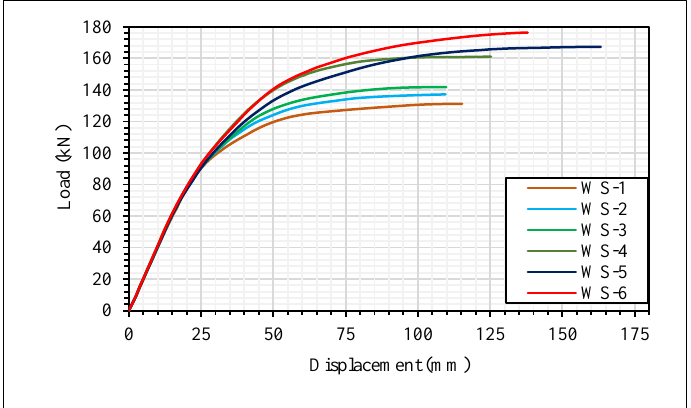
Figure 13. Web stiffener’s effect on the load-deflection curve of the curve